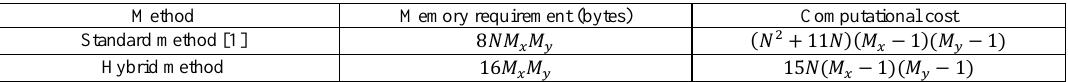
Table 1. Memory requirement and computational cost for the standard and hybrid